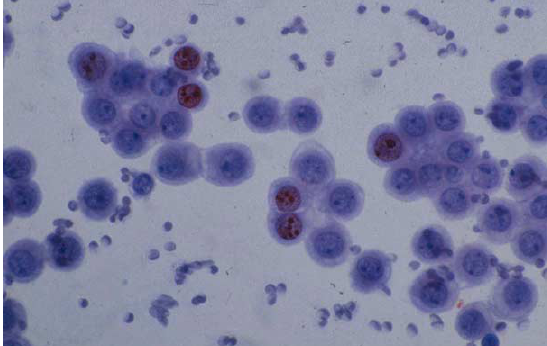
Fig. 3. ABC-method: staining of non-neoplastic mesothelial cells of a patient with an uterine cervical carcinoma with Ki67 and haema- toxylin (40 ×